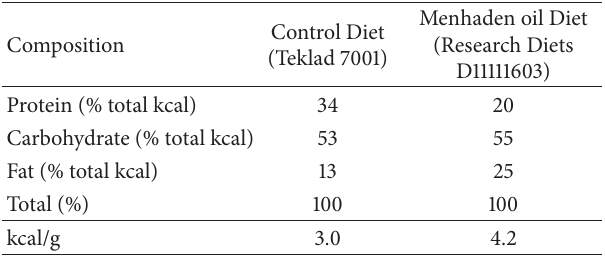
Table 1: Caloric composition of the